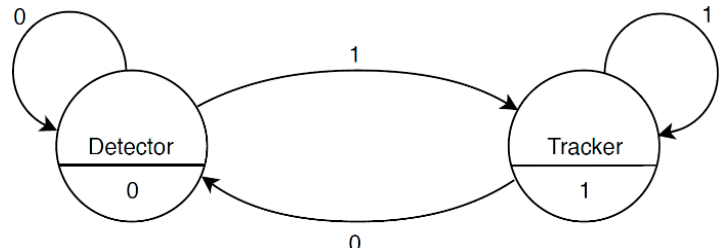
Figure 1. State diagram of the proposed architecture. Two cases are possible for the state of the system, namely target detected (1) or not detected (0). This relatively simple architecture is justified by the cooperative nature of the assumed multi-UAV system.